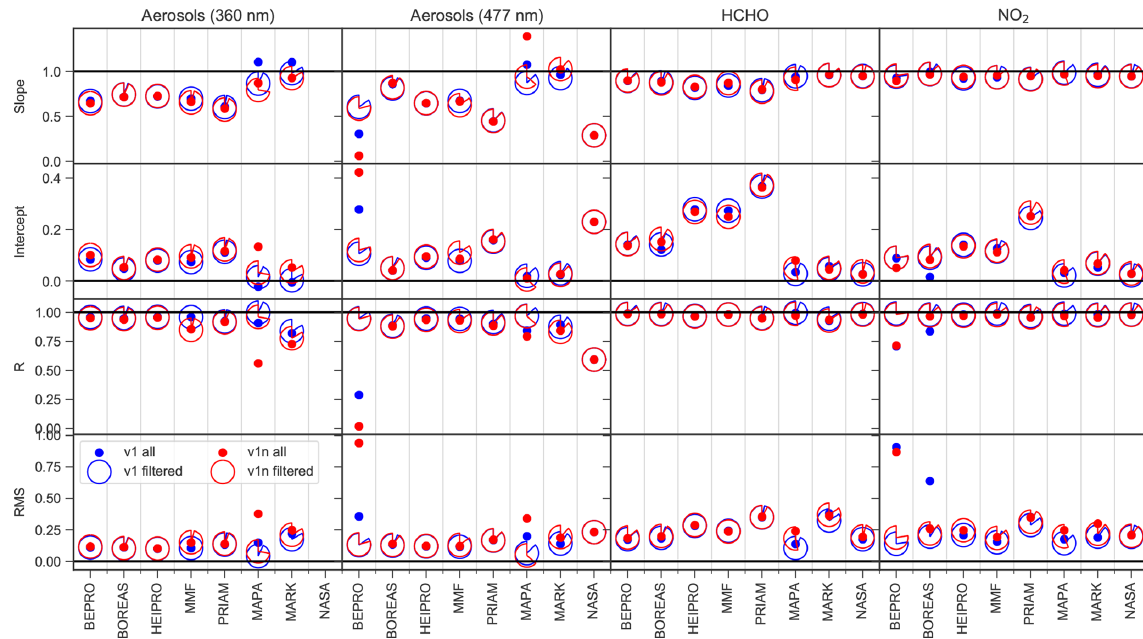
Figure 18. Slope, intercept, regression coefficient, and RMS for the correlation between true and retrieved AOT as well as HCHO and NO 2 VCD. Intercept and RMS values are in dimensionless units for aerosols and 10 16 moleccm − 2 for HCHO and NO 2 . Cloud and fog scenarios (AER8, AER9, AER10) are excluded from the regression